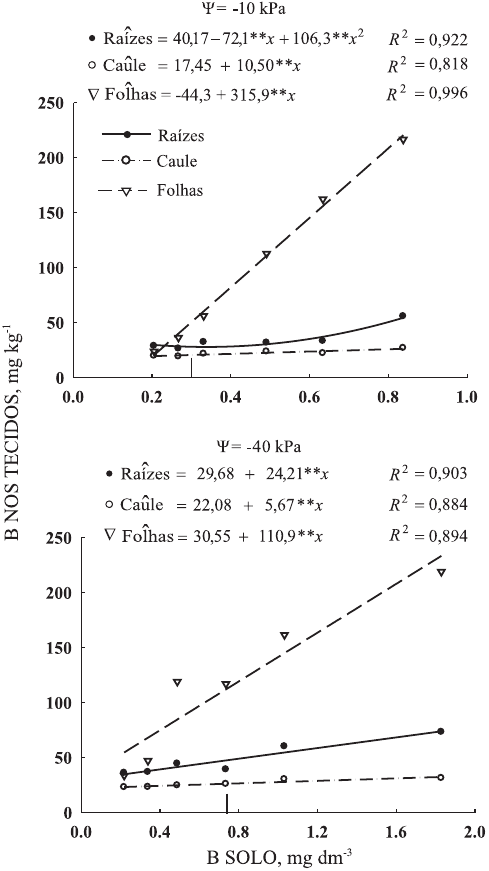
Figura 6. Teores de B nas raízes, caules e folhas do eucalipto em resposta ao teor de B no solo (B solo), considerando o potencial de água do solo ( ΨΨΨΨΨ ). O traço ( ⏐⏐⏐⏐⏐ ) corresponde ao B solo para obtenção da máxima produção de matéria de parte aérea.** significativo a 1 % pelo teste